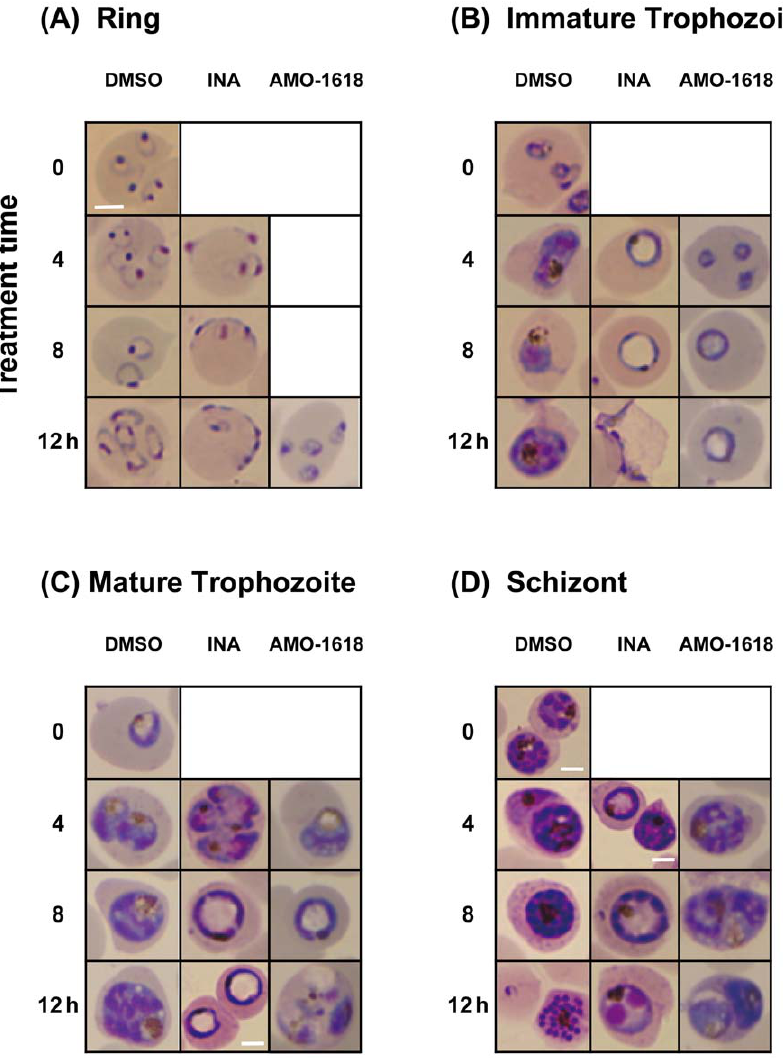
Figure 2. Effect of INA and AMO-1618 on intraerythrocytic development of P.falciparum . Tightly synchronized parasite cells that have undergone 5% sorbitol treatment and percoll density gradient centrifugation (window period: 4 h) were treated with 1 m l/ml DMSO, 50 m M INA or 250 m M AMO-1618 at different parasite stages: after 0 h (ring, A), 20 h (immature trophozoite, B), 28 h (mature trophozoite, C) and 36 h (schizont, D). Cultures were examined after 4, 8 and 12 h using Giemsa thin blood smears. Scale bar: 3 m m; all images without a scale bar are displayed at the same scale as the left uppermost image in (A).